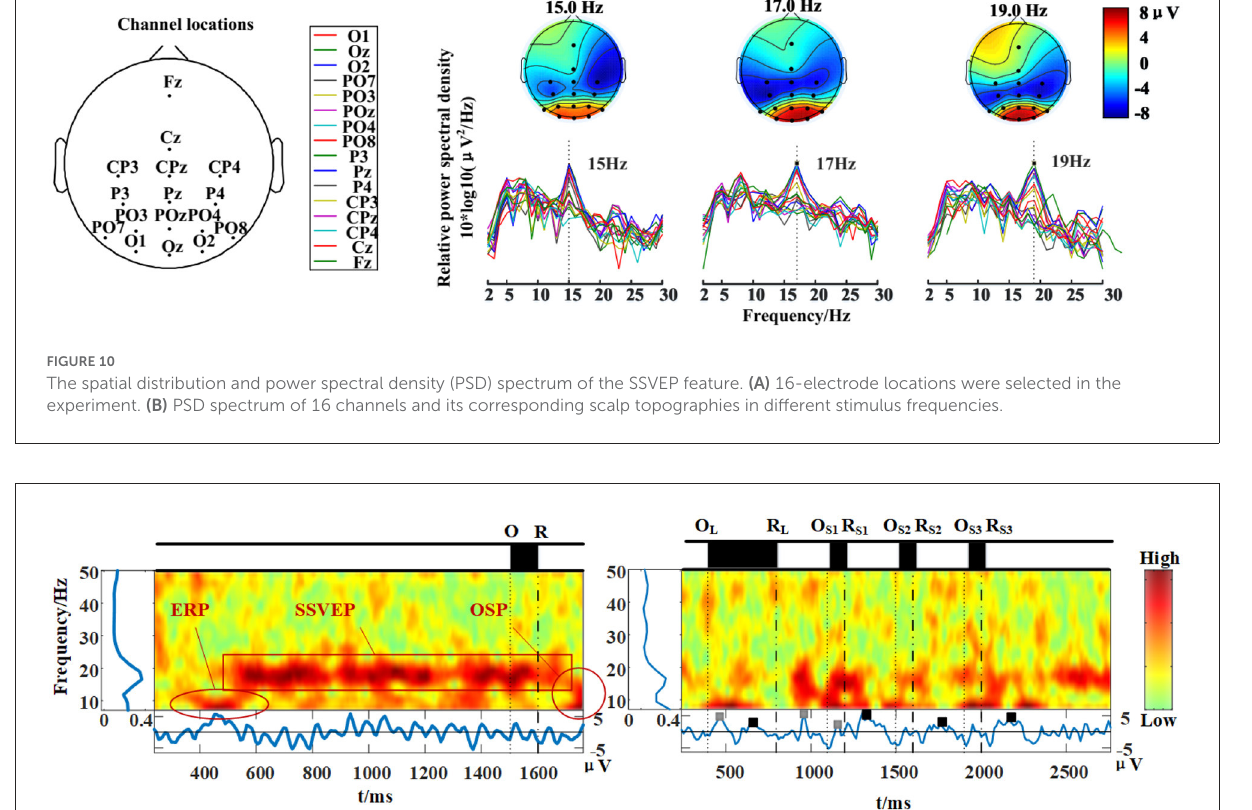
found this feature to be compatible with the SSMVEP paradigm, showing the same OSP with a positive peak at about 300ms after the omission (Bullock et al., 1994; McCullagh et al., 2009;